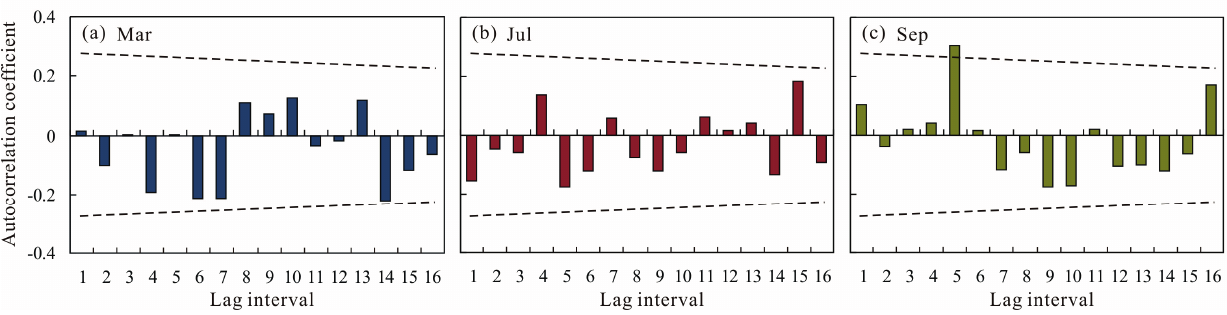
Figure 5. Autocorrelation coefficient of DWATI with different lag intervals in March ( a ); July ( b ) and September ( c ) (the dashed lines represent the confidence intervals at the 0.05 significance